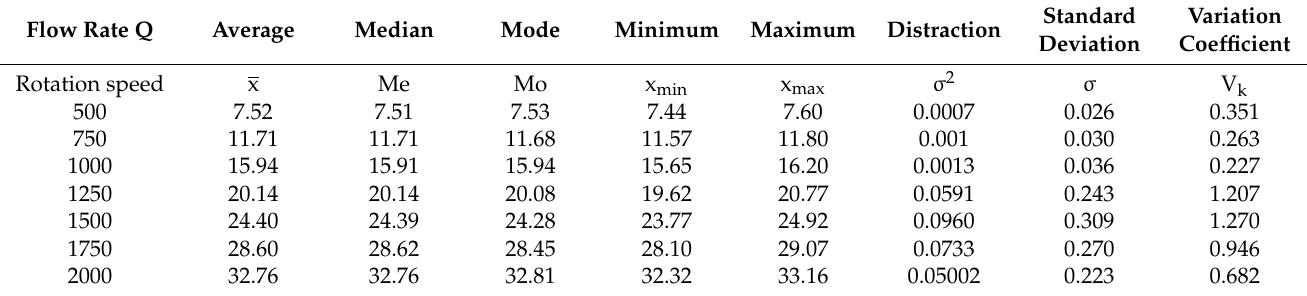
Table 8. Basic statistical evaluation, verification of flow characteristics of transducers in the primary circuit.